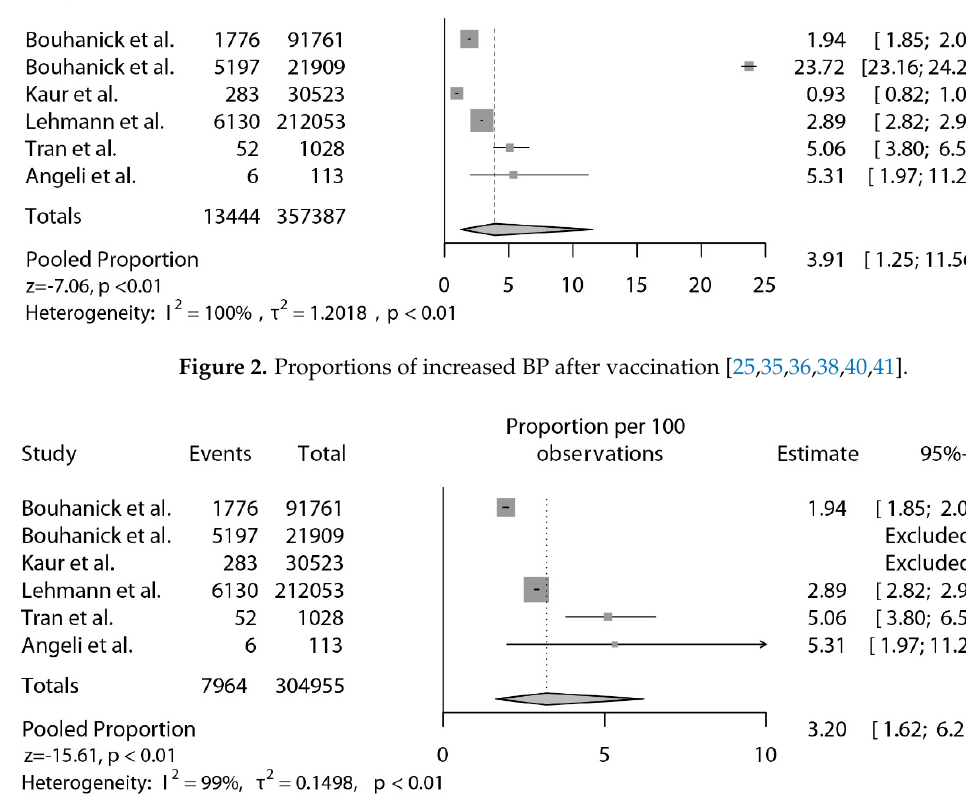
Figure 3. Proportions of increased BP after vaccination, after the exclusion of outlier studies.